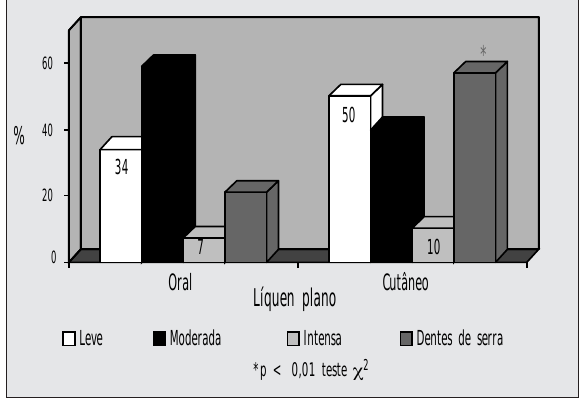
Figura 9 – Líquen plano cutâneo. Apagamento da camada basal, infiltrado inflamatório linfoistiocitário, melanófagos (seta) (HE, aumento original 400x)